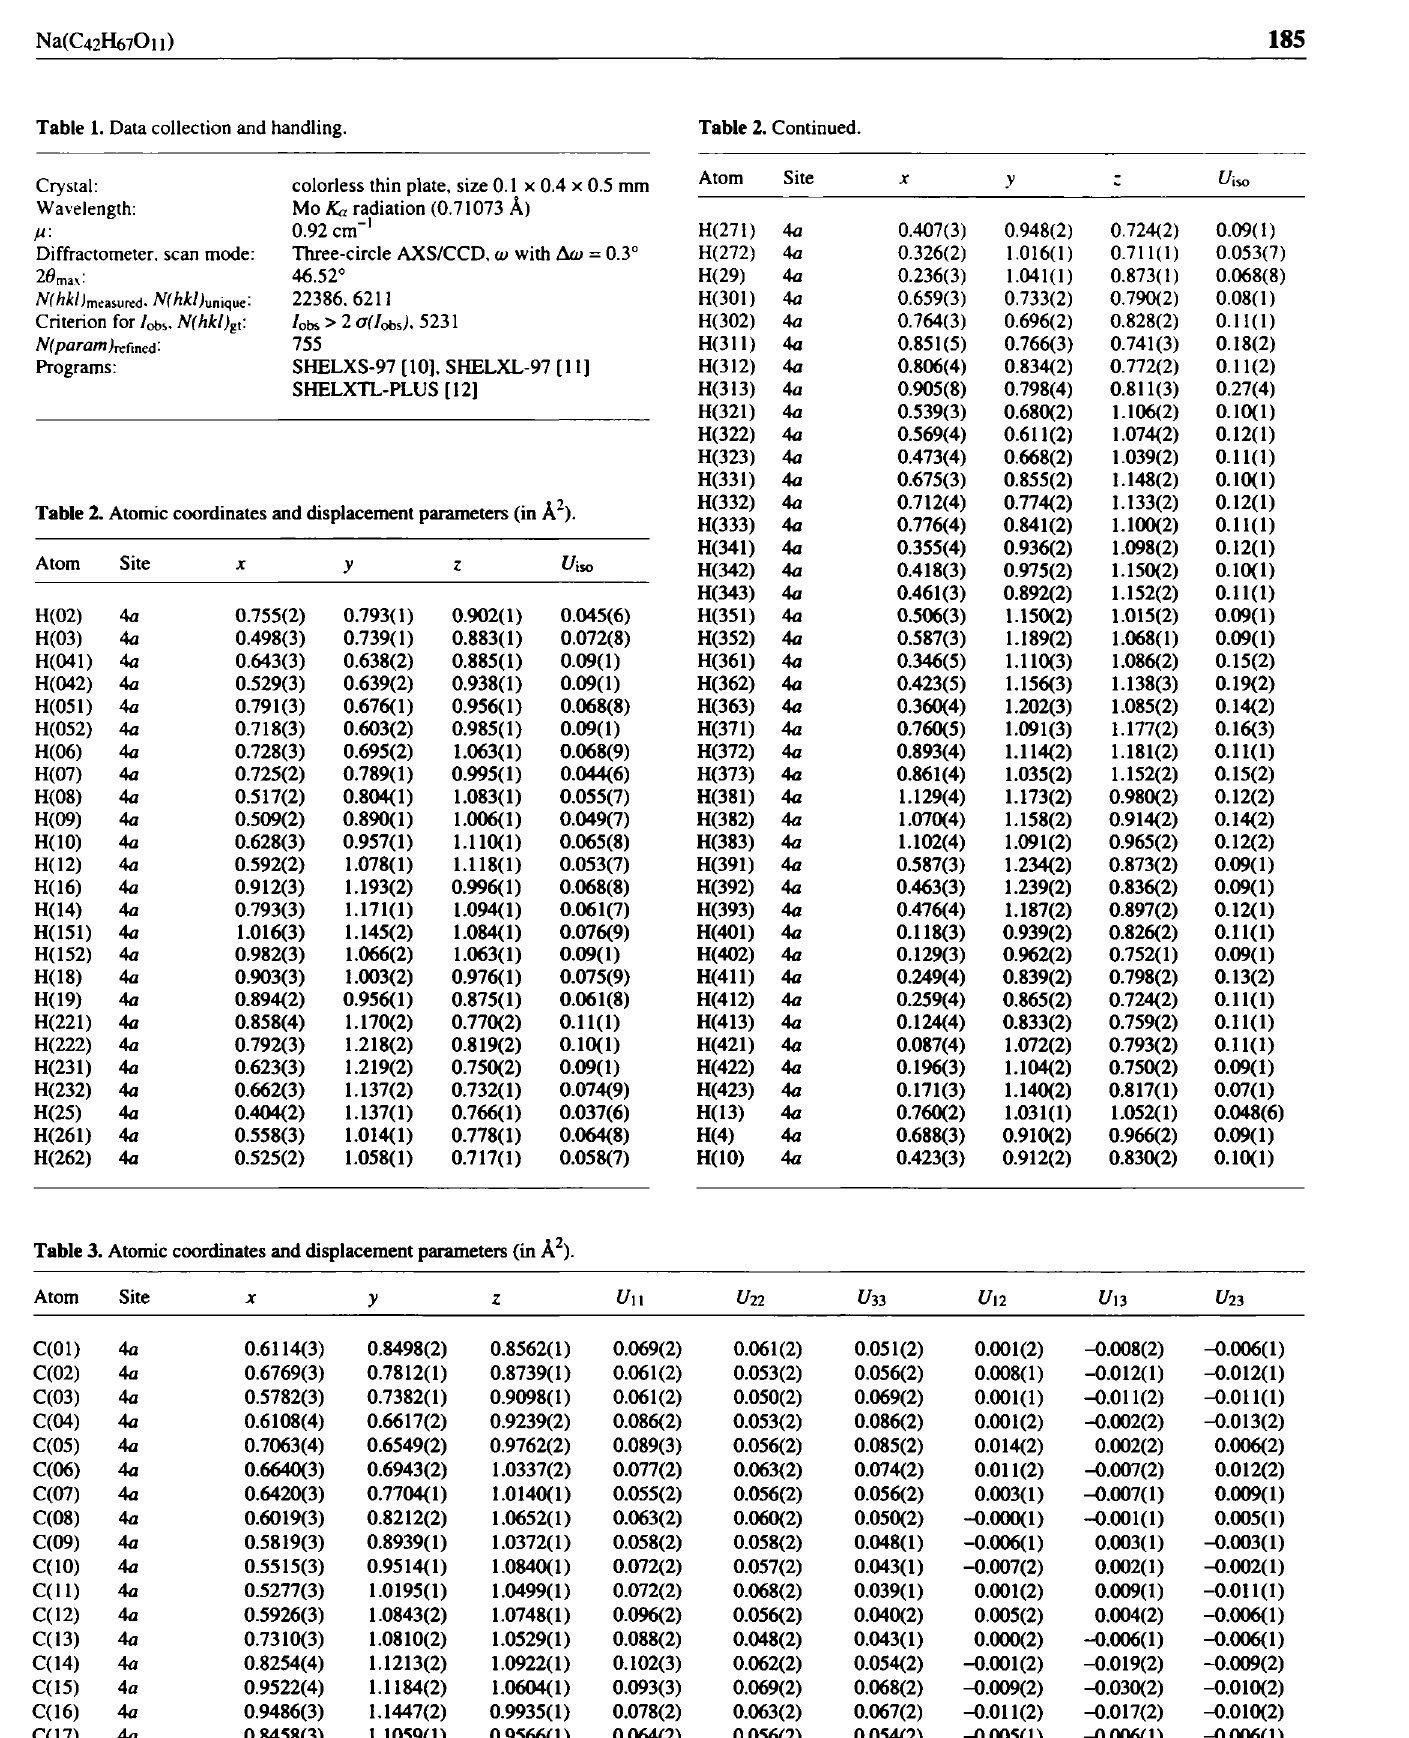
Table 3. Atomic coordinates and displacement parameters (in Ä 2